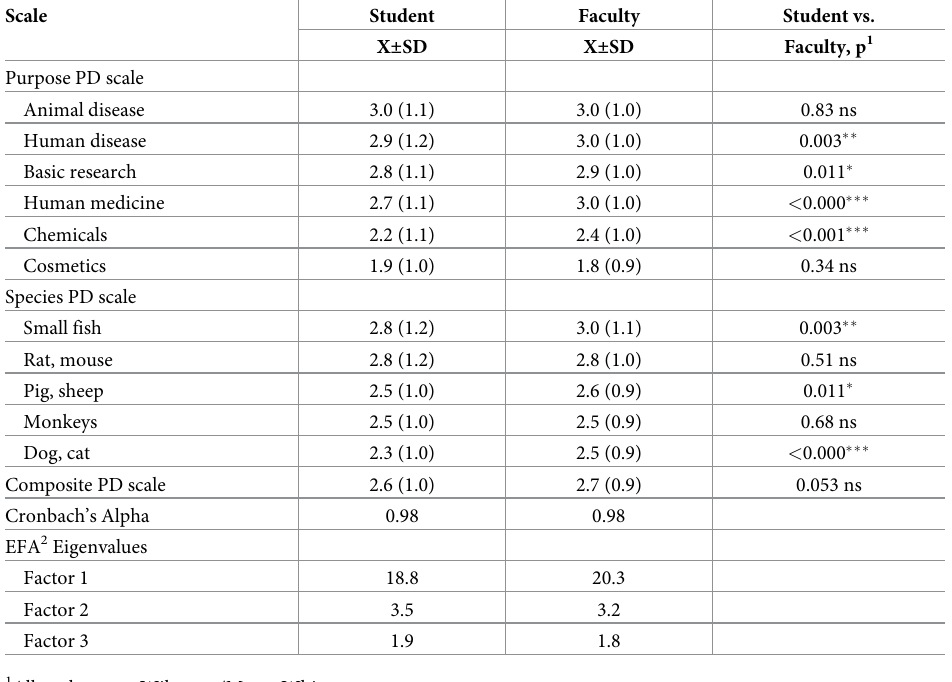
Table 5. ARAS-PD purpose scale, species scale, and composite scale scores (1–5